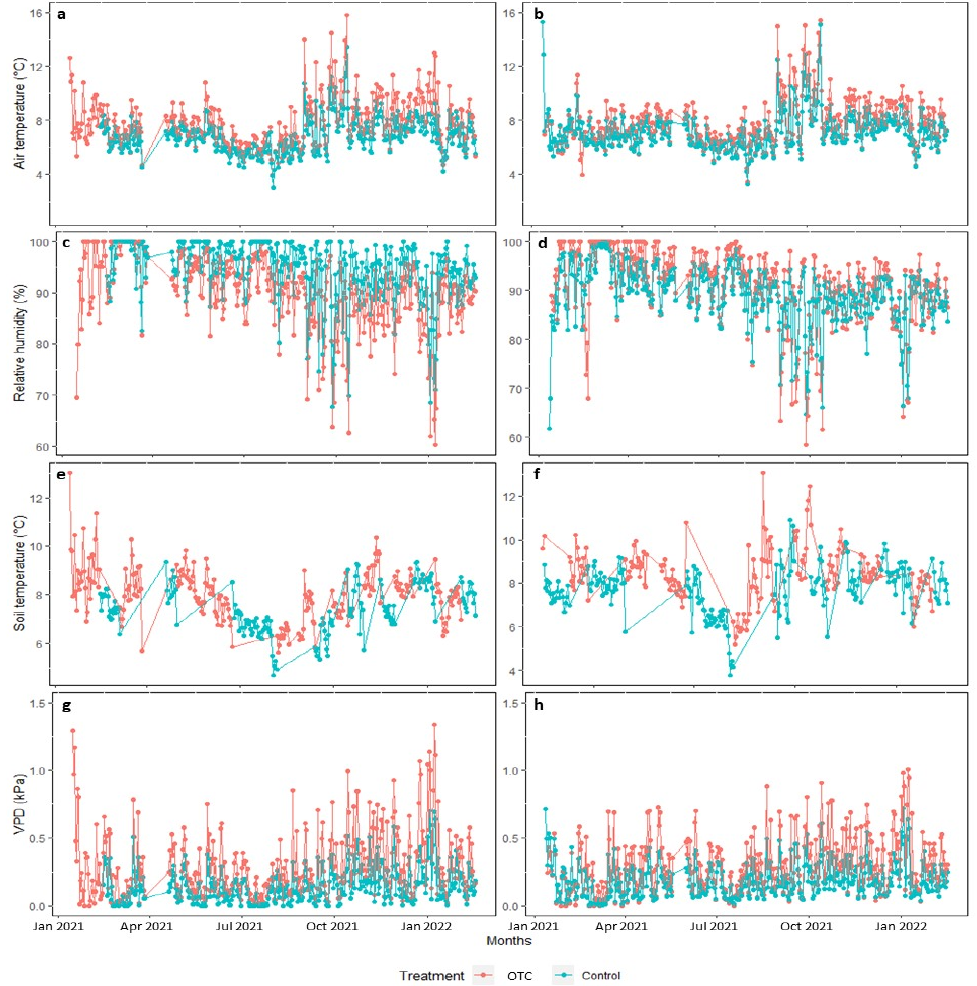
Figure 1. Climatic parameters throughout the experiment, daily mean values of air temperature (°C), relative humidity (%), soil temperature (°C), and pressure deficit of environmental value-DPV (kPa) in the two study areas. ( a , c , e , g ) conserved area and ( b , d , f , h ) intervened area, subjected to passive warming in the OTC treatment (red) and without passive warming in the control treatment (blue).